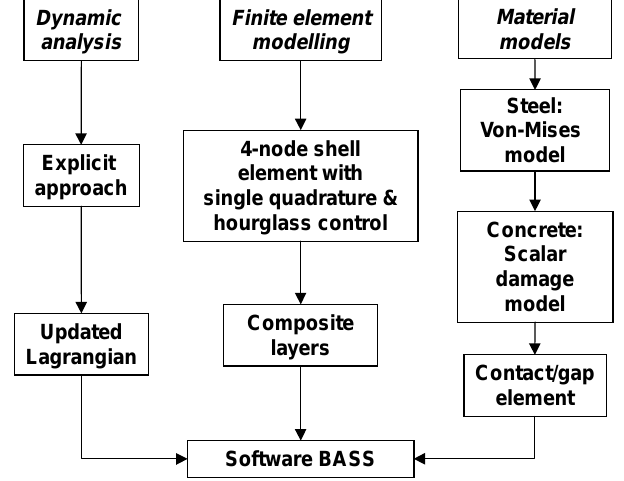
Fig. 2. Main features of software